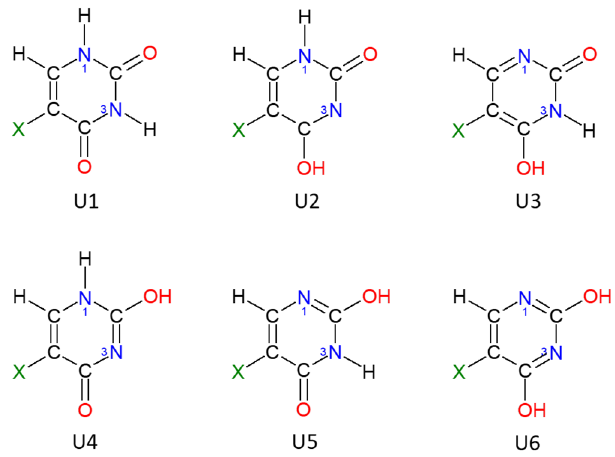
Figure 2. Tautomers of uracil (U, X = H) and its 5-halogen derivatives (5XU, X = F, Cl, Br or I).